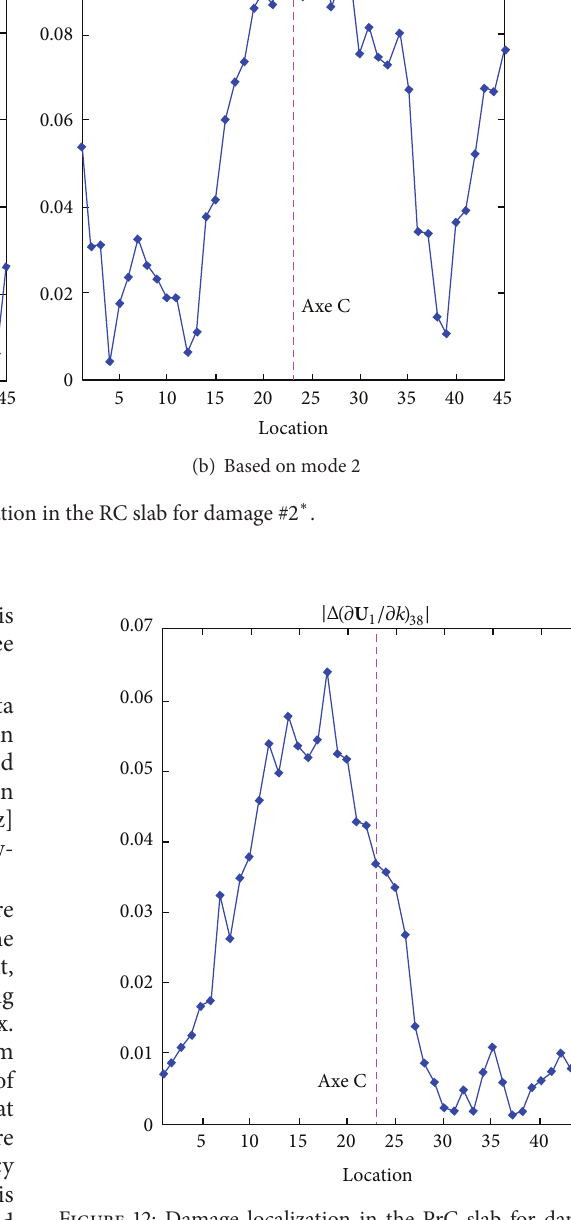
Figure 12: Damage localization in the PrC slab for damage # 2 ∗ , based on mode